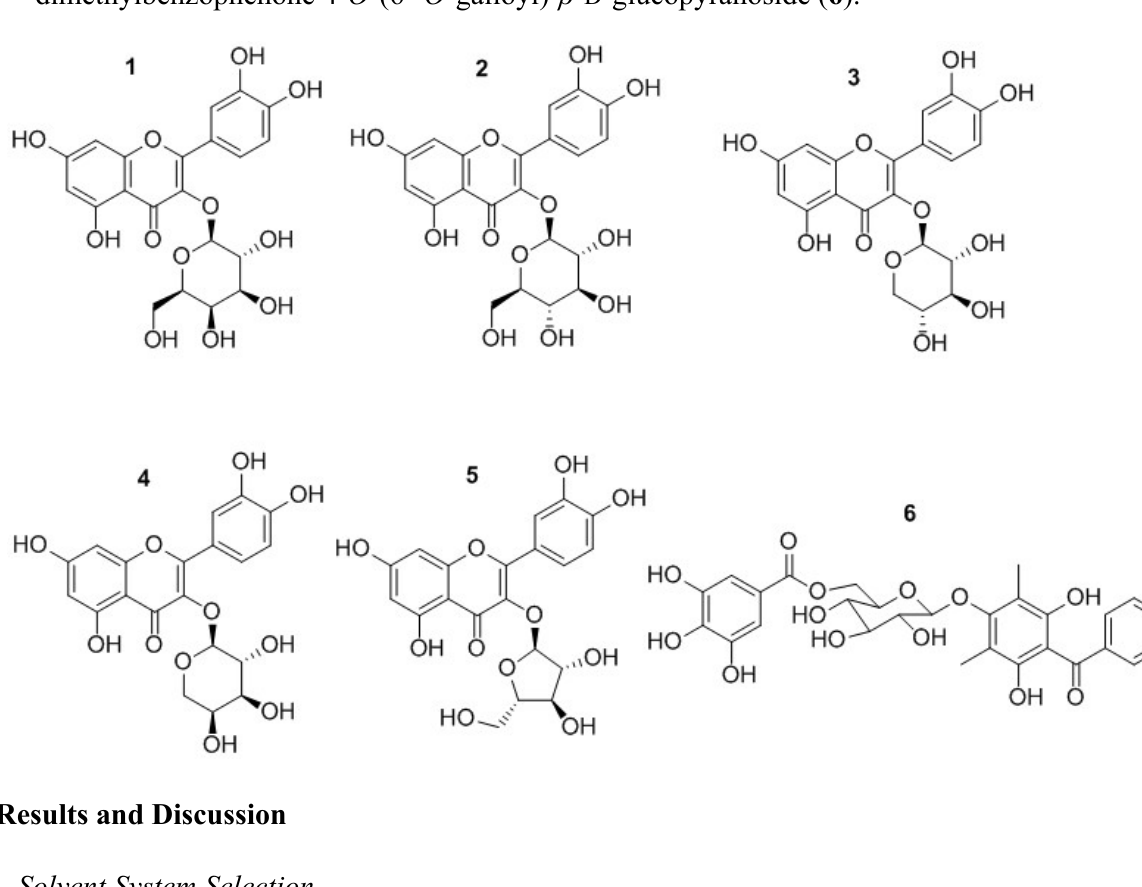
Figure 1. Chemical structures of five flavonoid glycosides and one benzophenone galloyl glycoside from of P. guajava leaves: quercetin-3- O- β - D -galactopyranoside ( 1 ), quercetin- 3- O- β - D -glucopyranoside ( 2 ), quercetin-3- O- β - D -xylopyranoside ( 3 ), quercetin-3- O- β - D - arabinopyranoside ( 4 ), quercetin-3- O- α - L -arabinofuranoside ( 5 ),